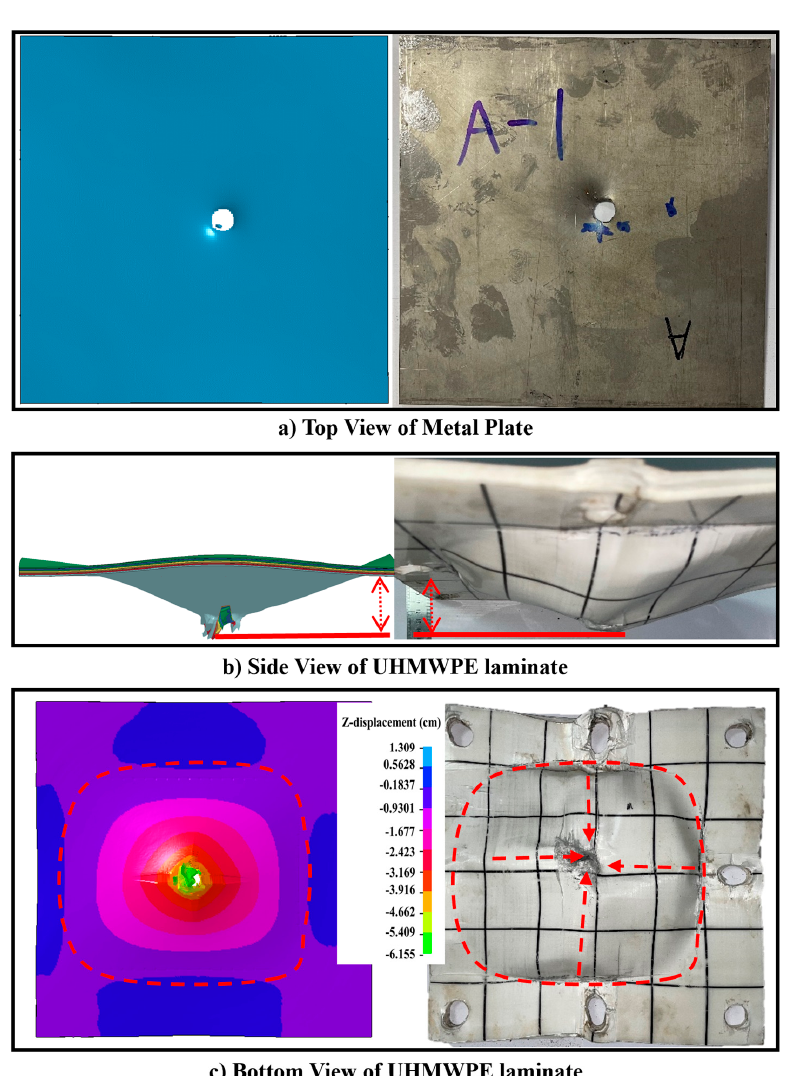
Figure 7. Simulated damage and deformation of front plate and UHMWPE laminate. ( a ) Top view. ( b ) Side view. ( c ) Bottom view.